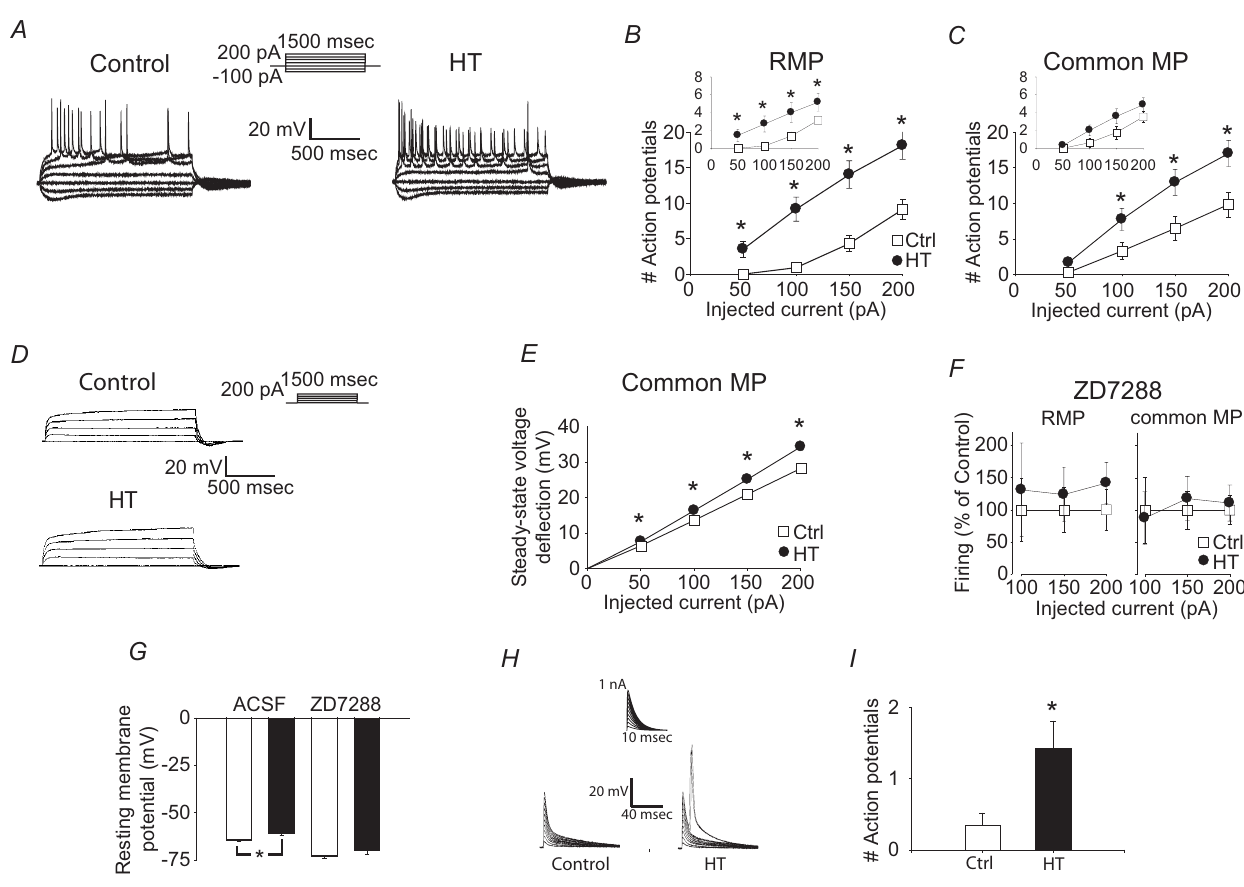
Figure 2. Whole cell recordings from CA1 pyramidal apical dendrites show that h-current alterations are not solely responsible for hyperexcitability. (A) Whole cell, current clamp recordings of control (left) and HT (right) dendrite responses to 1500 ms long current injections from RMP. Recording distance 200 µm from soma. (B) Number of action potentials fi red in response to 1500 ms depolarizing current injections in control (open squares) and HT (fi lled circles) dendrites from the RMP. (C) Number of action potentials fi red in response to 1500 ms depolarizing current injections in control (open squares) and HT (fi lled circles) dendrites from a − 60 mV holding potential. Insets: Number of action potentials in the fi rst 300 ms of the depolarizing current injections. Note that the data in (B) and (C) are from the same population of dendrites, before and after compensation of the RMP difference by constant current injection. (D) Whole cell, current clamp recordings of control (top) and HT (bottom) dendrite responses to 1500 ms long current injections (recording distance: 200 µm) in the presence of 1 µM TTX, from a − 60 mV holding potential. (E) Steady-state voltage defl ection of control (open squares) and HT (fi lled circles) dendrites in response to 1500 ms current injections from a − 60 mV holding potential. (F) Action potentials fi red (% of control) in control (open squares) and HT (fi lled circles) dendrites in the pres- ence of ZD7288, from RMP (left) and from a − 70 mV holding potential (right; recording distance: 200 µm). (G) RMP of control (white bars) and HT (black bars) dendrites in the absence or presence of ZD7288. (H) Control and HT dendritic responses to artifi cial EPSPs generated by current injection from the